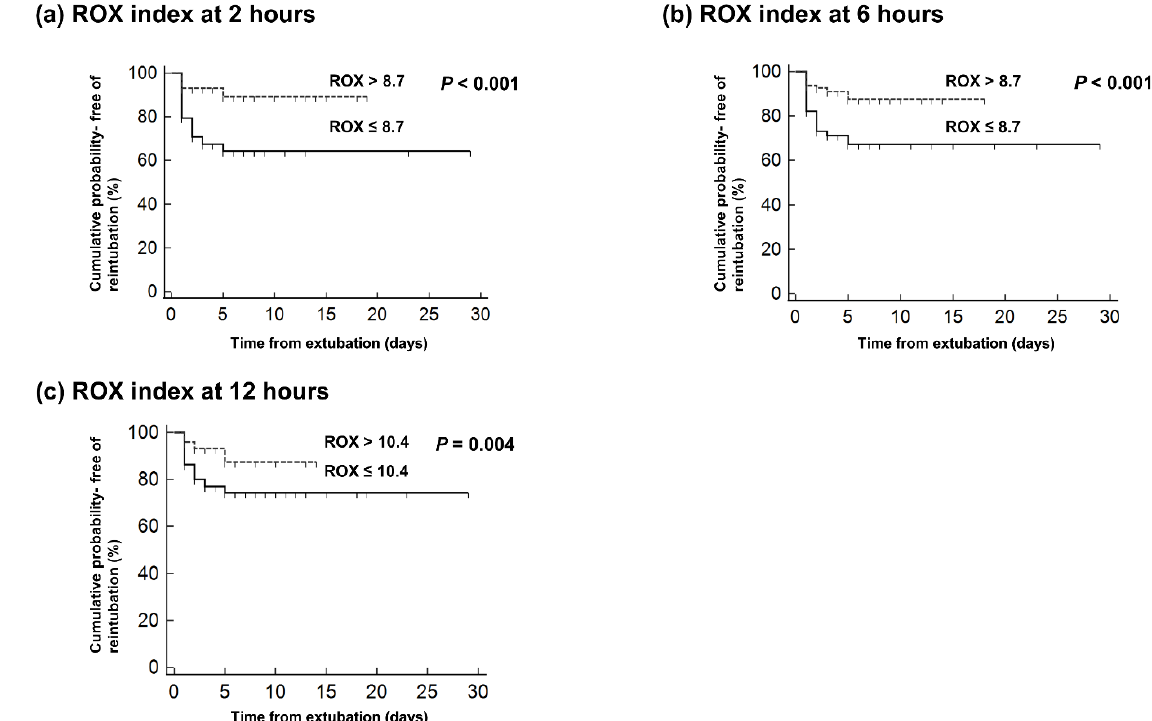
Figure 2. Kaplan–Meier plots showing the cumulative probability of remaining free of reintubation according to the cut-off ROX index value at ( a ) 2 h, ( b ) 6 h, and ( c ) 12 h after the commencement of HFNC therapy in extubated patients.